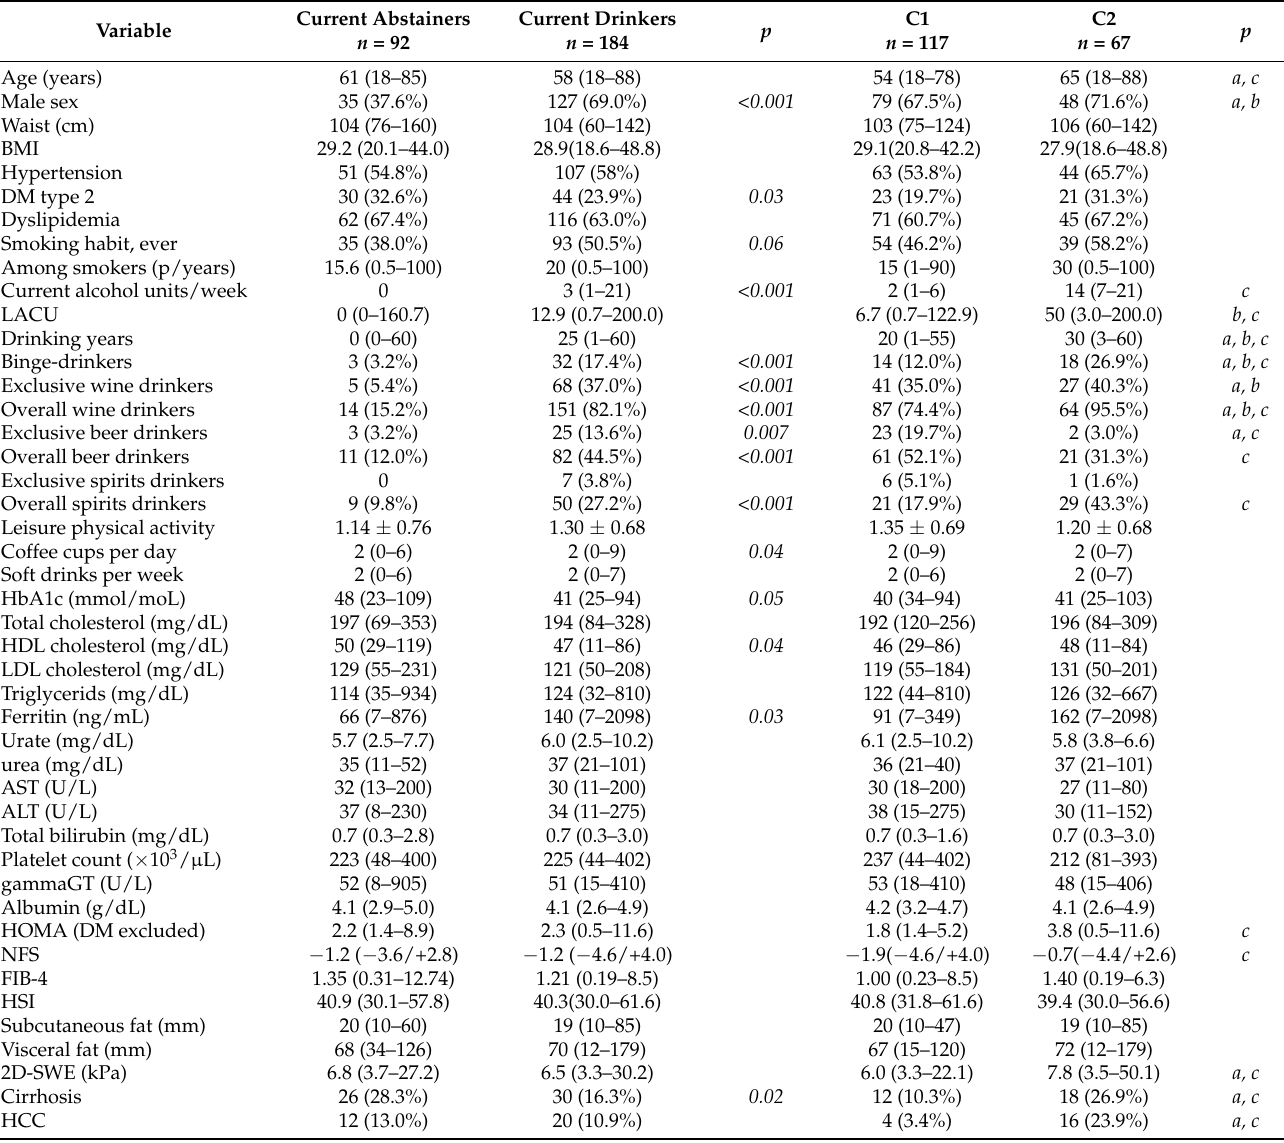
Table 2. Patient characteristics according to current alcohol intake per